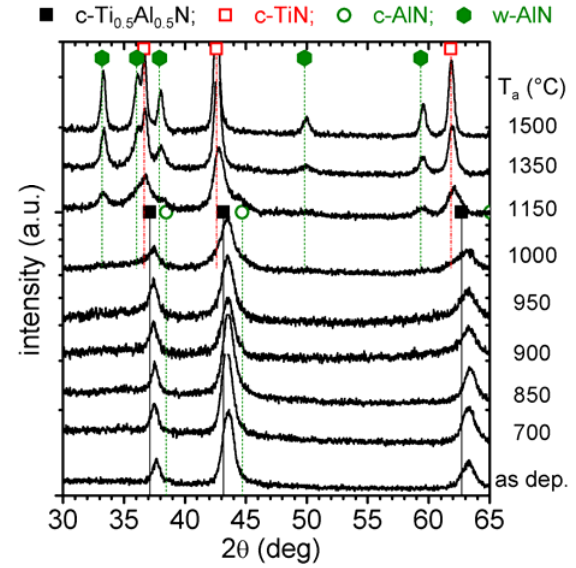
Figure 2. XRD evolution of c-Ti up to 1500